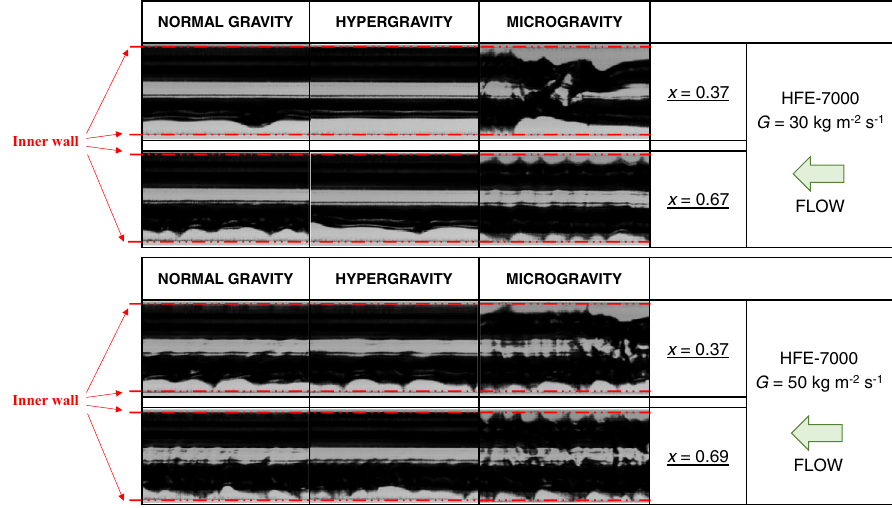
Fig. 3 Flow pattern visualizations with the varying gravity level. Flow pattern visualizations during two-phase fl ow of HFE-7000 inside the 3.38 mm inner diameter channel at mass velocity G = 30 kg m − 2 s − 1 (top) and G = 50 kg m − 2 s − 1 (bottom) and different vapor qualities, performed in normal gravity, hypergravity and microgravity conditions (Berto et al. 28 ).